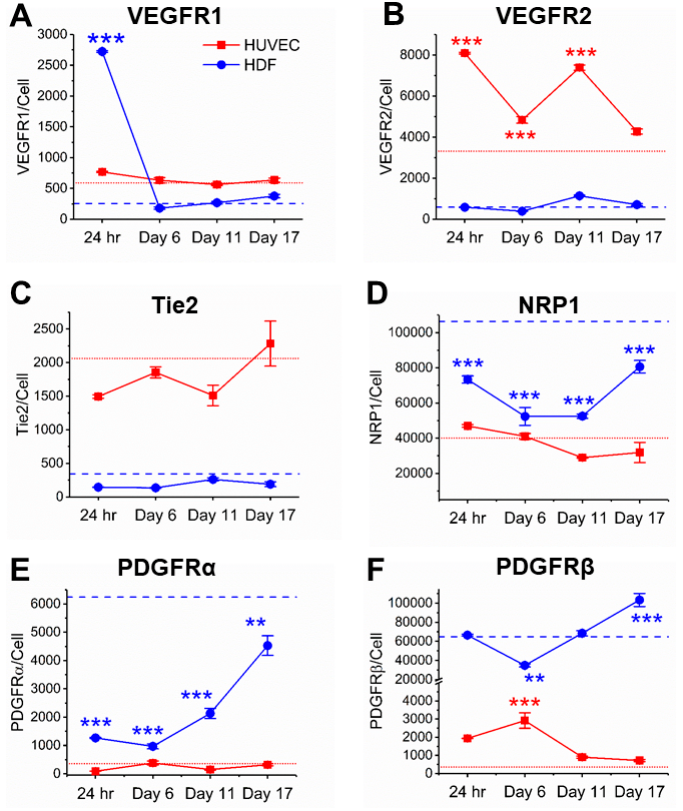
Figure 2. Quantification of angiogenic receptor concentrations on HUVECs and HDFs following 24-h, 6-day, 11-day, and 17-day coculturing. Dashed lines represent receptor concentrations of collagenase-treated monocultures when they reach 80–90% confluency. Red: HUVECs; Blue: HDFs. Mean ± SEM of receptor concentrations in cocultures were compared to monocultures and ANOVA Tukey test was performed to determine the significant differences (* indicates p < 0.05, ** indicates p < 0.01, and *** indicates p < 0.001). VEGFR: Vascular endothelial growth factor receptor; PDGFR: Platelet-derived growth factor receptor; NRP: Neuropilin.